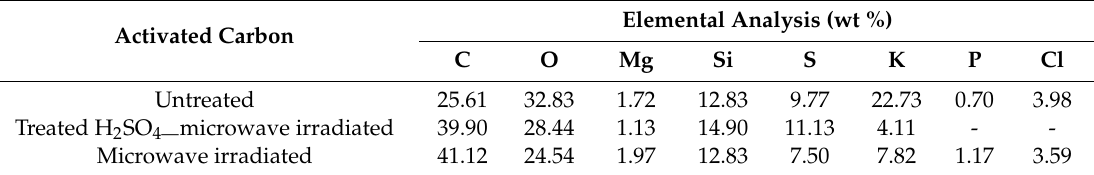
Table 4. Elemental analysis of untreated, H 2 SO 4 –microwave-irradiated, and microwave-irradiated POMB-retained ash.